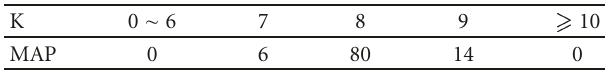
Table 3: Estimated frequency values for the measured MB response. Estimates (Freq.)